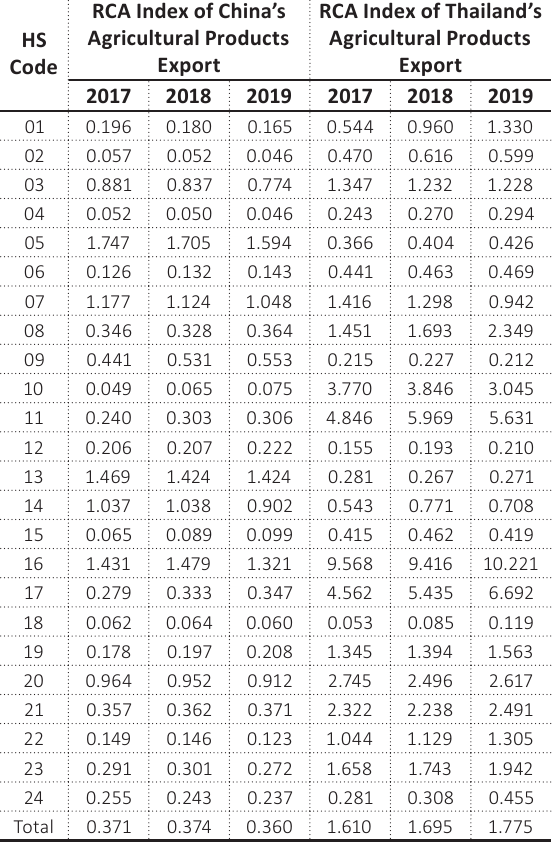
Table 2. Revealed comparative advantage